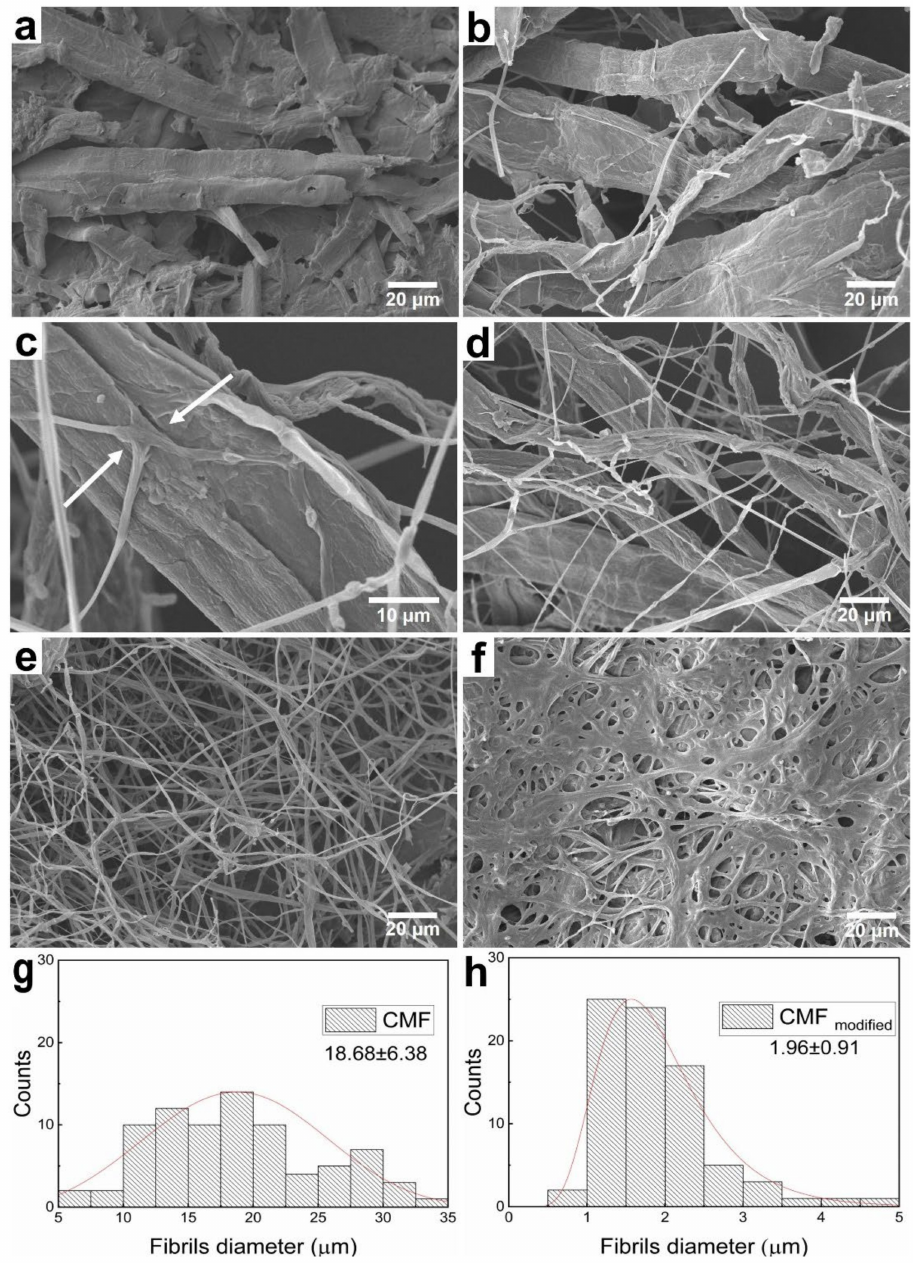
Figure 1. The biotransformation of microfibrillar cellulose: pristine CMF ( a ); mycelium cultiva- tion: 3 days ( b ); hyphae growth from the microfibril structure (arrows indicate the fungi attach- ment) ( c ); 1 week ( d ); 2 weeks ( e ); 3 weeks ( f ); diameter size distribution: pristine cellulose ( g ); and CMF modified ( h